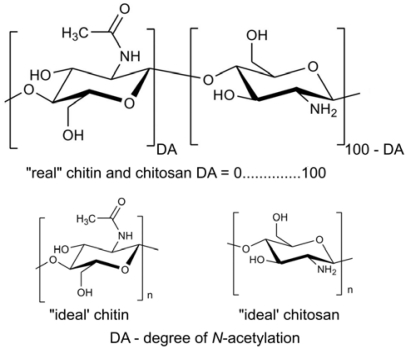
The chemical structures of chitin and chitosan.